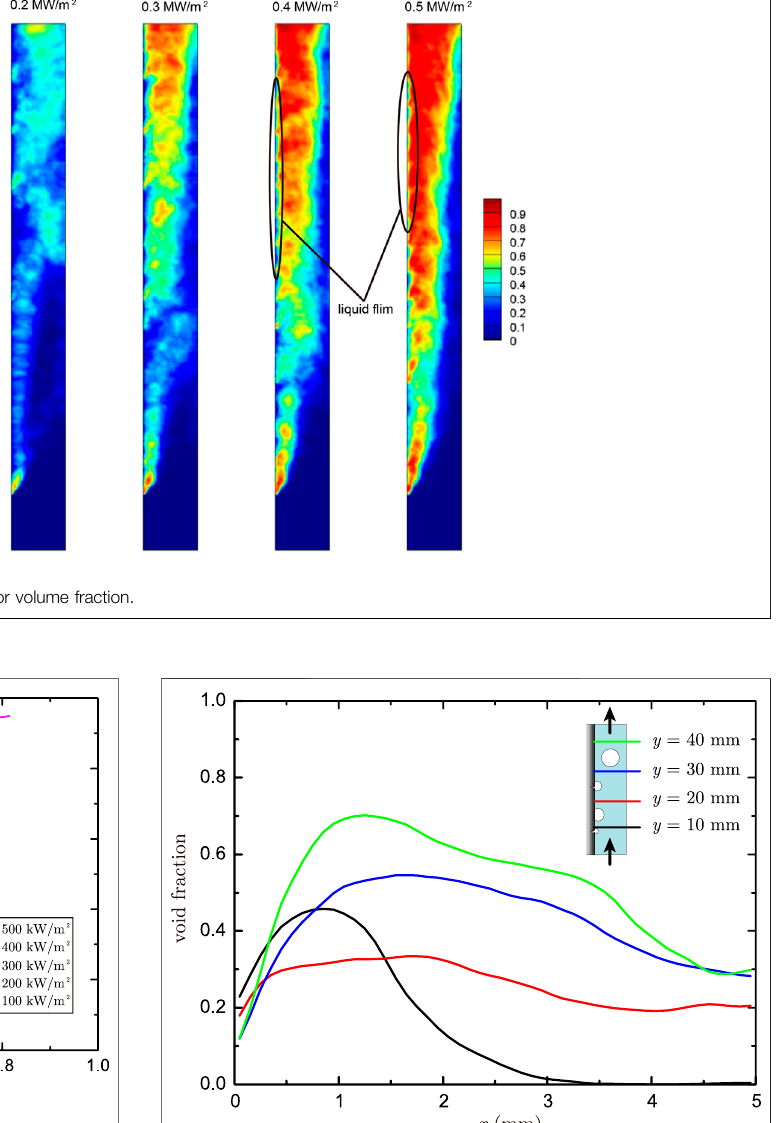
FIGURE 13 | Average void fraction along the fl ow direction.